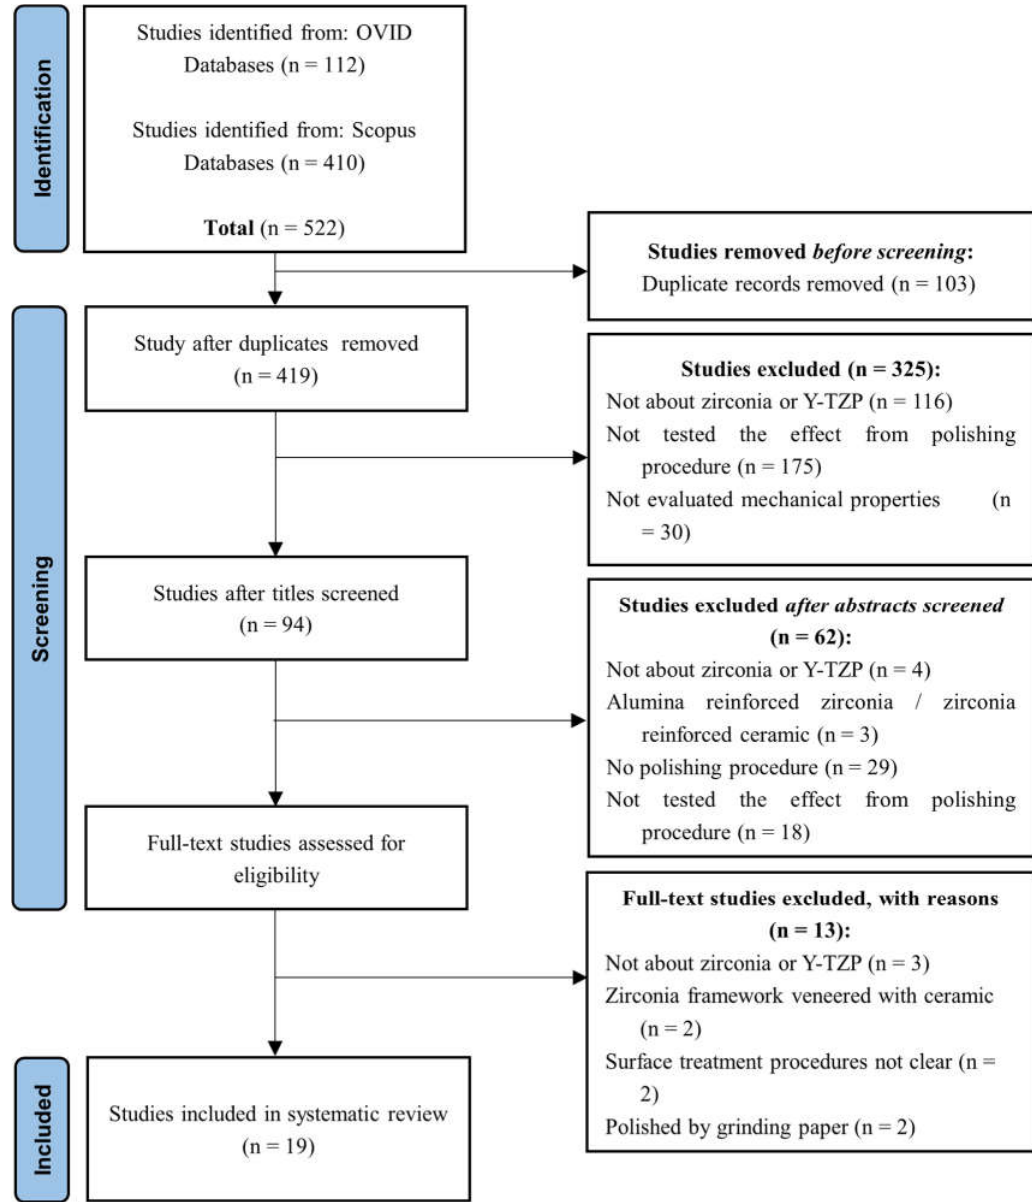
Figure 1. PRISMA flow diagram of study identification.